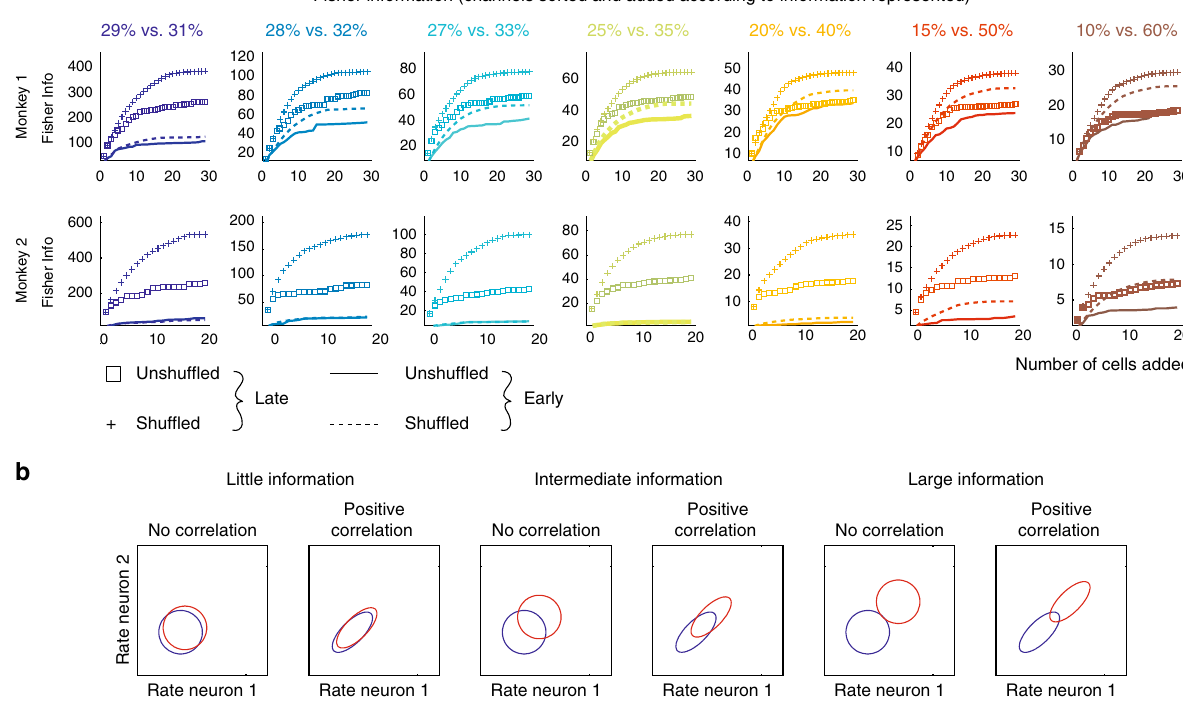
Fig. 7 Information in populations of different sizes before and after learning. a Fisher information in a population of consecutively added channels for early (solid and dashed lines in each subplot) and late recording days ( + and squares in each subplot). Colour coding shows the Fisher information for the different test contrast pairs investigated/decoded. ‘ Unshuf fl ed ’ indicates that the channel identity and the correlation structure was retained during calculation of Fisher information (squares and solid lines). ‘ Shuf fl ed ’ indicates that trials between channels were shuf fl ed to remove the rate correlations, while retaining channel identity ( + and dashed lines). Abscissa: number of channels that were added to the population. Ordinate: Fisher information present. Channels were added based on their rank-order single-channel information content, starting with the channel encoding the most information. b Cartoon that exempli fi es how noise correlation reduction differentially affects population decoding abilities, depending on the amount of information represented in individual neurons. The circles/ellipses indicate the response co-variability between two hypothetical neurons. Blue circles/ellipses show correlation of responses for one potential stimulus, red circles/ellipses for a different stimulus. The further the blue and red circles/ellipses are apart the larger the information single channels represent. Two scenarios (no correlation vs. positive correlation) for three different information contents (little information, intermediate information, large information) are shown. Reduction in overlap between the two stimulus-induced response distributions is maximal when neurons have relative large information